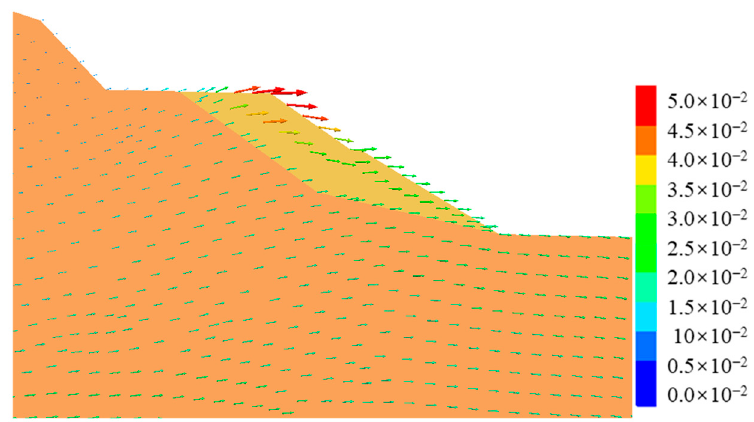
Figure 10. Displacement contour of the cut-and-fill subgrade after earthquake.